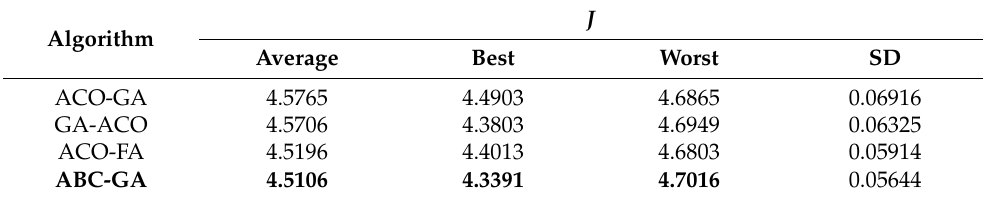
Table 7. Comparison of the objective function values obtained by ABC with the published ones.